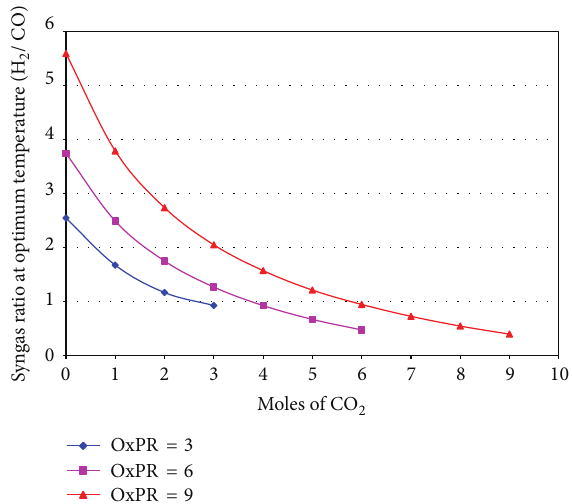
Figure 8: Syngas ratio at optimum temperature in CR of propane.